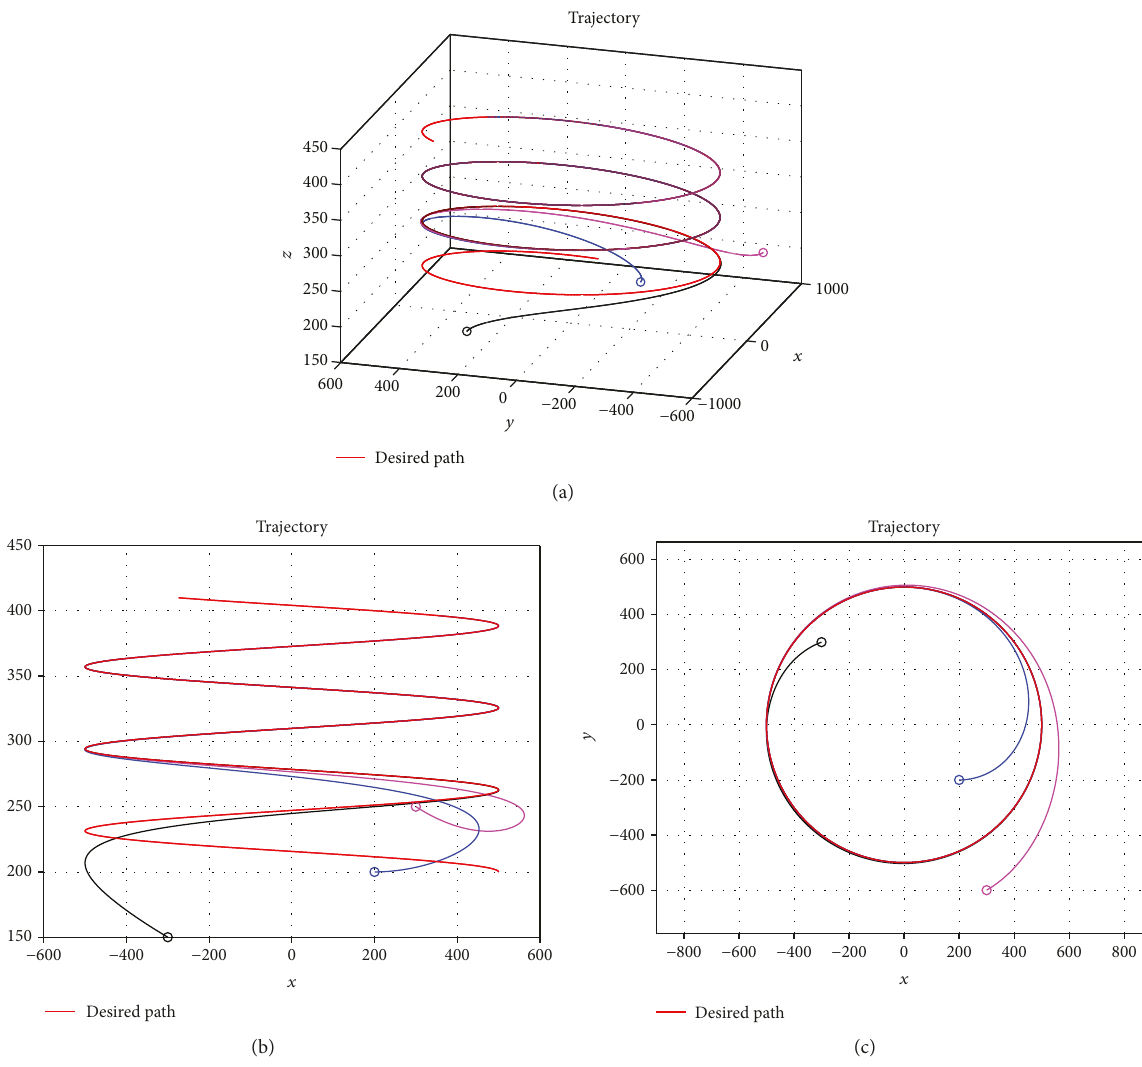
Figure 9: Helical path following. (a) Three-dimensional view, (b) side view, and (c) planar view.